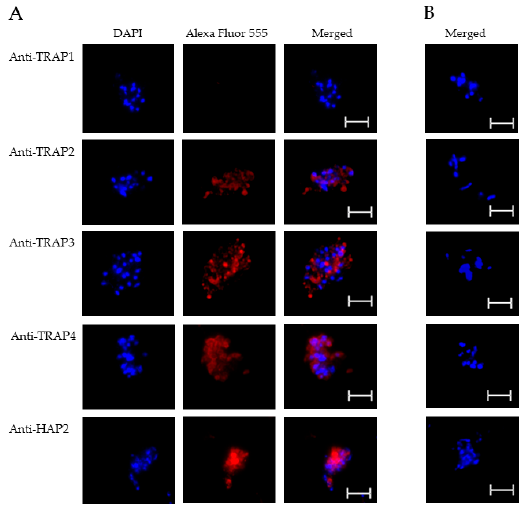
Figure 3. Evaluation of TRAP protein expression by B. bovis sexual stages using a fixed immunofluorescence assay incubated with anti-TRAP 1, 2, 3, 4, or HAP2. Panels are ( A ) immune and ( B ) pre-immune rabbit serum. Blue indicates DAPI stained DNA and red indicates anti-rabbit IgG Alexa Fluor 555 reactivity. Scale bar: 5 µm. The results indicated that TRAP2, 3, and 4 were expressed by B. bovis blood and sexual stages. Anti-HAP2 antibody, as expected, reacted only with B. bovis sexual stages